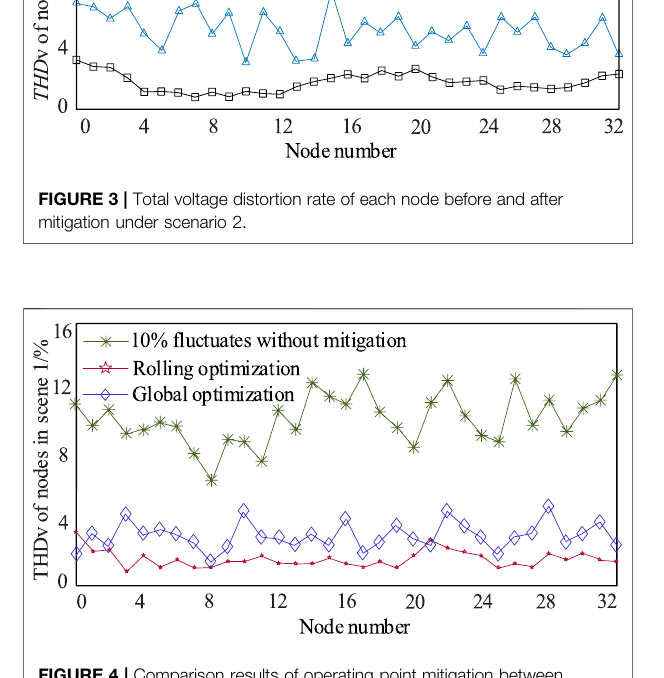
FIGURE 4 | Comparison results of operating point mitigation between rolling optimization and global optimization under scenario 1.